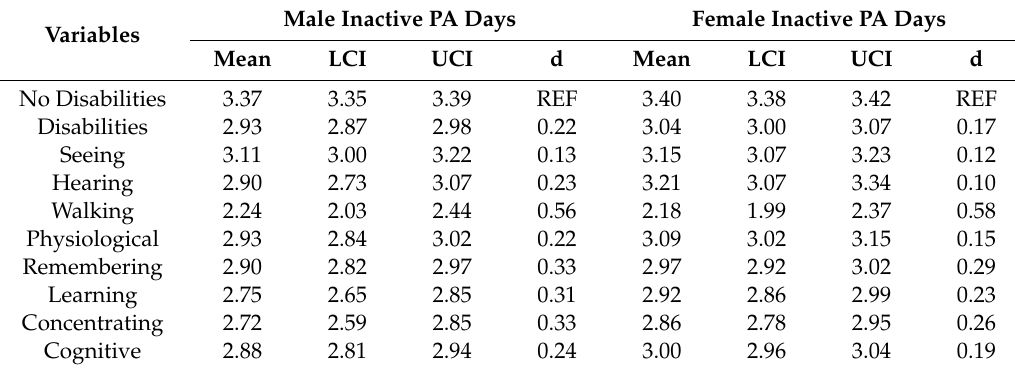
Table 4. Di ff erences in adjusted means, 95% confidence intervals of moderate-to-vigorous physical activity (MVPA) days by sex with e ff ect sizes with no disabilities as comparison